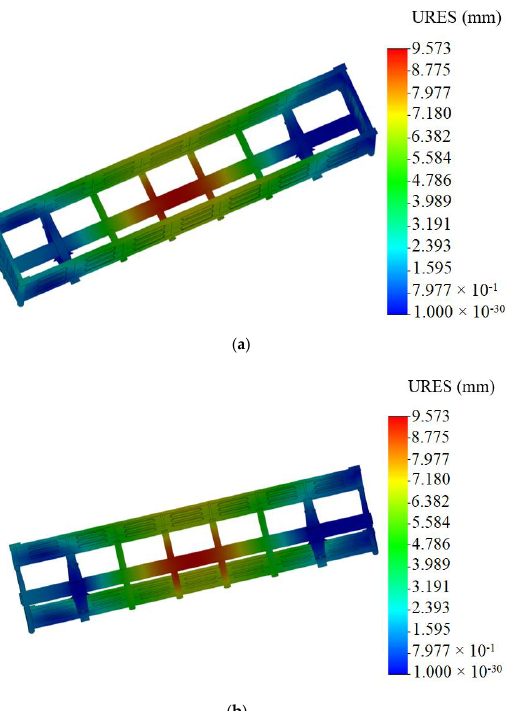
Figure 5. Stressed state of carrying structure of open wagon ( a ) top view; ( b ) bottom view. The maximum equivalent stresses emerged in the bottom part of the center sill behind the rear draft lug and accounted for about 320 MPa. The maximum displacements were fixed in the middle part of the center sill and were 9.5 mm (Figure 6). The maximum deformations were 3.64 × 10 − 3 (Figure 7).